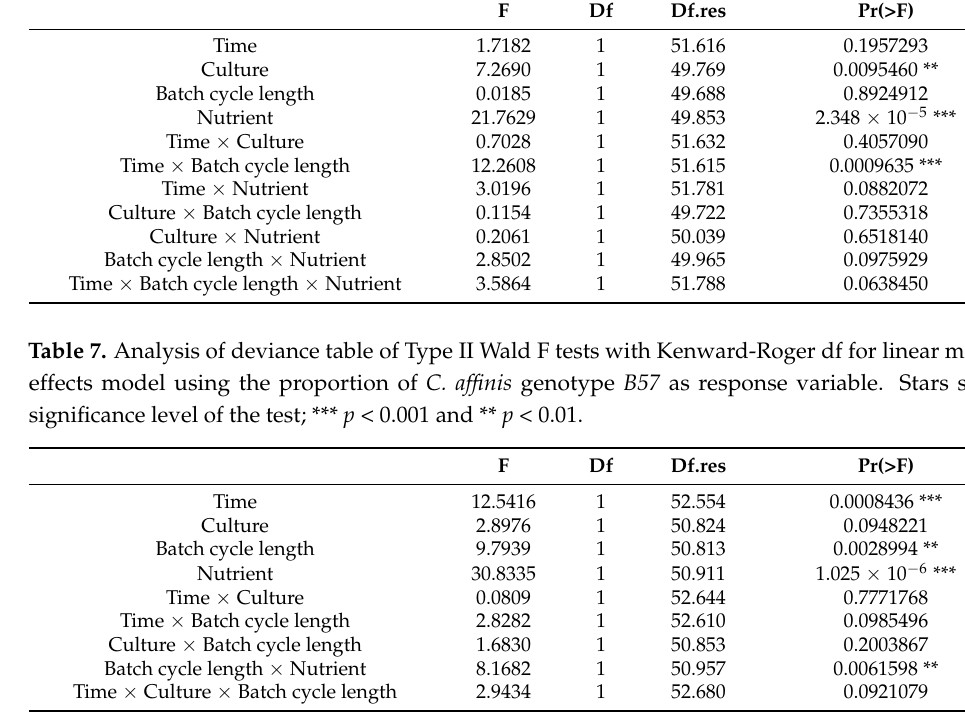
Table 6. Analysis of deviance table of Type II Wald F tests with Kenward-Roger df for linear mixed- effects model using the proportion of C. affinis genotype B82 as response variable. Stars show significance level of the test; *** p < 0.001 and ** p < 0.01. F Df